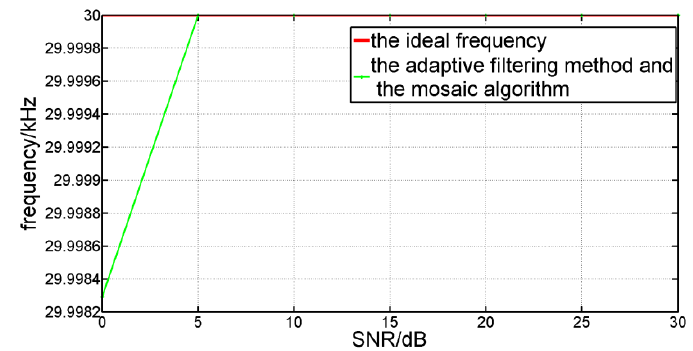
Figure 5. Comparison between the ideal frequency and the simulated result.